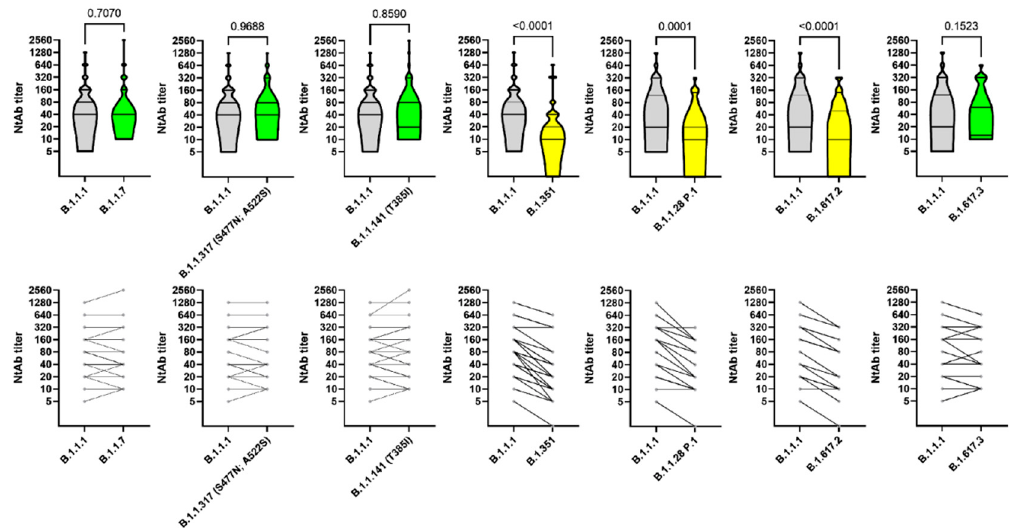
Figure 3. Serum neutralization titers against variants of SARS-CoV-2. The upper graphs show violin plots for serum samples, the lower graphs indicate the individual VNT changes. Geometric mean and 95% CI and p-value (Wilcoxon test) is noted on upper graphs. Number of used serum samples is noted on lower graphs.